Question: Summarize what this figure shows in one sentence.
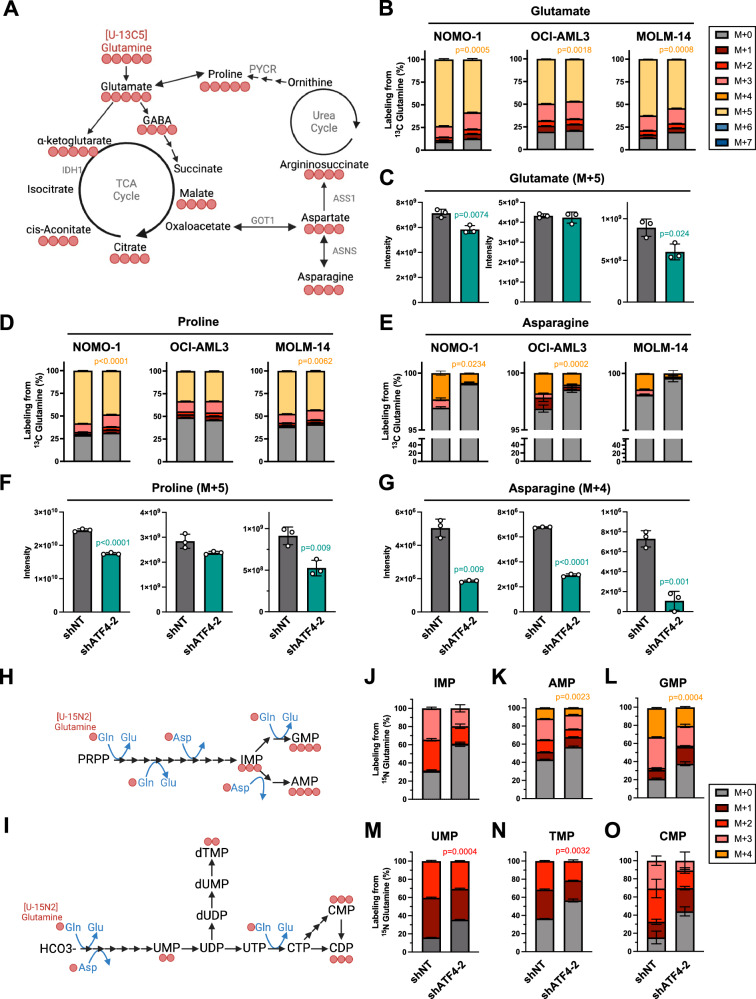
Answer: ATF4 regulates glutamine-derived amino acids and subsequent nucleotide synthesis. A Schematic of U- 13 C-Glutamine isotopologue catabolism. TPMs extracted from NOMO-1, OCI-AML3, or MOLM-14 cells from each shRNA condition were subjected to HILIC-MS (Created in BioRender. Basse, M. (2026) https://BioRender.com/2mdtpav ). B Percent (%) U- 13 C-Glutamine isotopologue labeling of Glutamate. C Total levels of M + 5 Glutamate labeled from U- 13 C-Glutamine. D , E % U- 13 C-Glutamine isotopologue labeling of Proline ( D ) and Asparagine ( E ). F , G Total levels of M + 5 Proline ( F ) and M + 4 Asparagine ( G ) labeled from U- 13 C-Glutamine. For panels, B , D , and E , data represent the mean ± SD of three technical replicates. Two independent, biological replicates were performed for NOMO-1 cells and one independent, biological replicate for each OCI-AML3 and MOLM-14 cells. Statistics are derived from a two-way ANOVA (95% CI) comparison between the shNT control and shATF4-2 conditions. Šídák’s multiple comparisons test was applied to compare each label fraction between shNT and shATF4-2 conditions. p -values in ( B , D ) represent a comparison of the M + 5 label fraction between shNT and shATF4-2 conditions. p -values in ( E ) represent a comparison of the M + 4 label fraction between shNT and shATF4-2 conditions. Exact adjusted p -values are listed in the Source Data File. For panels ( C , F , G ), data represent the mean ± SD of three technical replicates. Two independent, biological replicates were performed for NOMO-1 cells and one independent, biological replicate for each OCI-AML3 and MOLM-14 cells. Statistics are derived from a two-sided, unpaired t -test (95% CI) comparing the shNT control and shATF4-2 (teal p -values) conditions. Adjustments for multiple comparisons were not made, and exact p -values are listed in the Source Data File. H , I Schematic of U- 15 N -Glutamine utilization in purine synthesis ( H , Created in BioRender. Basse, M. (2026) https://BioRen